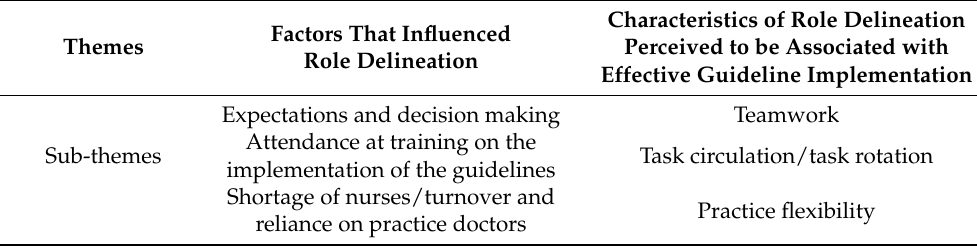
Table 2. Identified themes and